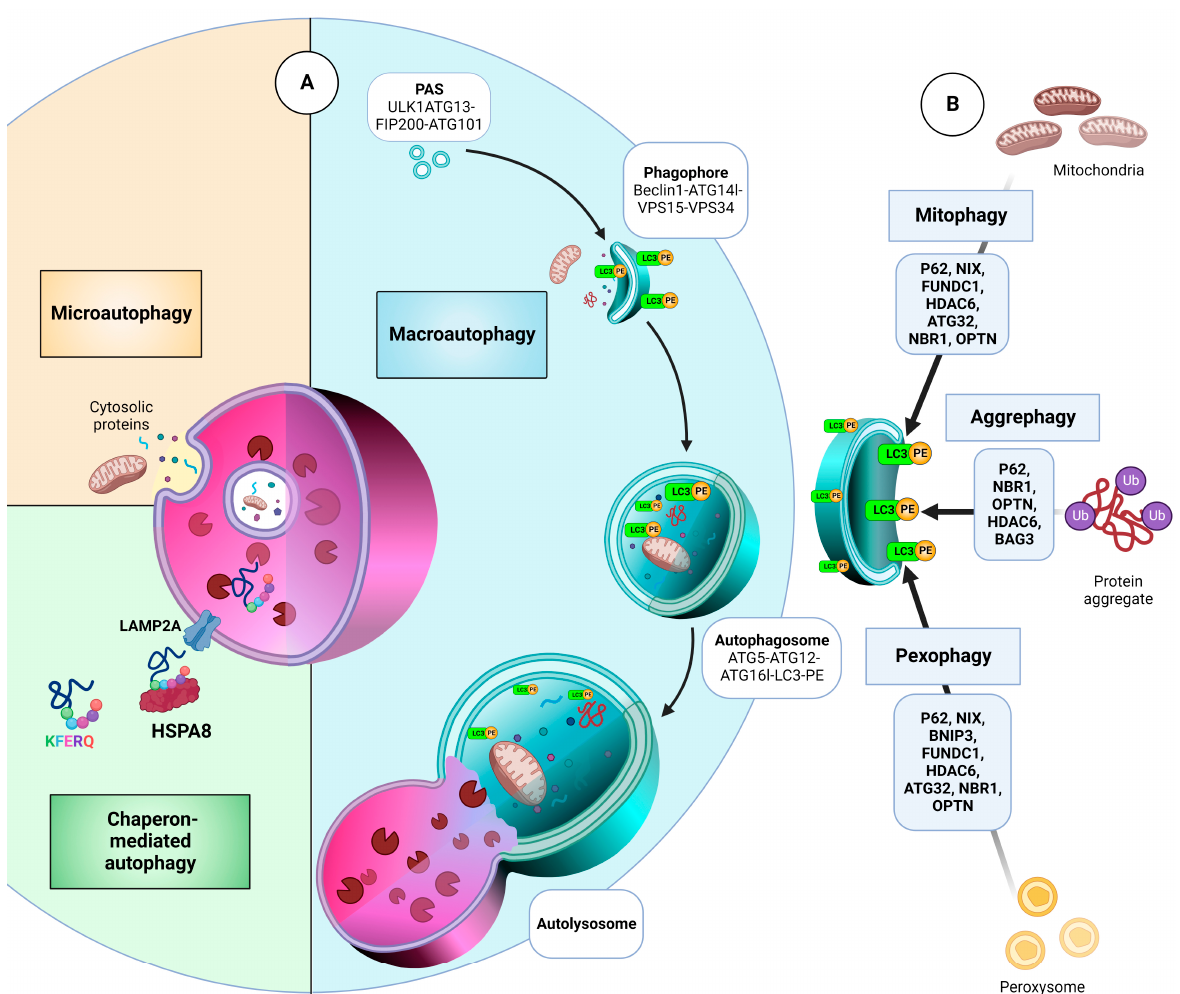
Figure 1. Autophagy is a self-eating mechanism occurring in cells. ( A ) Different steps in the autoph- agy pathway. Cargos are first engulfed by autophagosomes, which then fuse with lysosomes. Lysosomal enzymes degrade the cargo resulting in the recycling of the cargo’s building blocks. ( B ) Se- lective autophagy. Autophagy can selectively target and degrade specific cargo using different re- ceptor proteins.